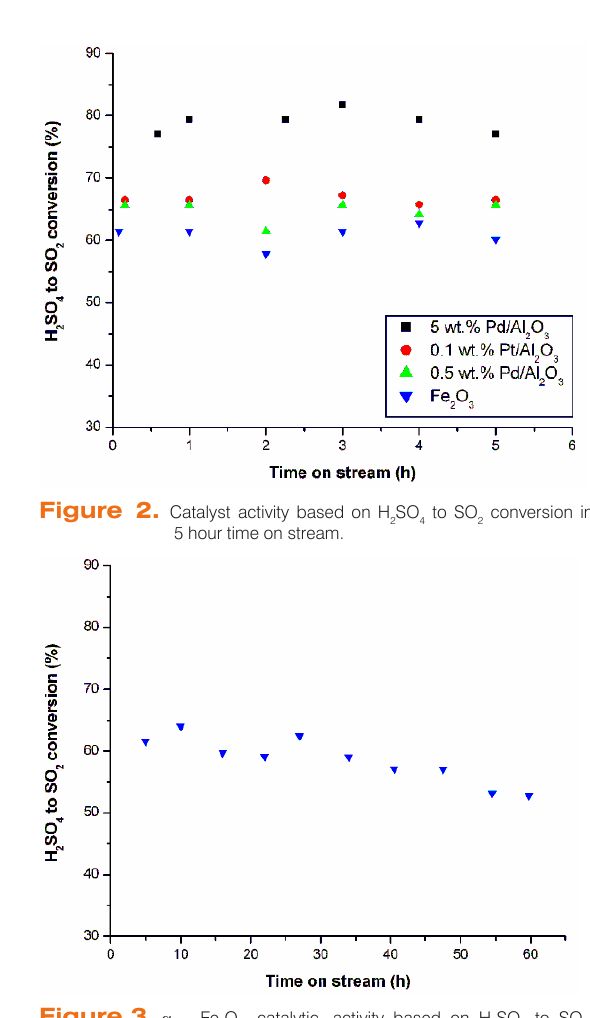
O catalytic activity based on H 2 3 conversion in 60 hour time on